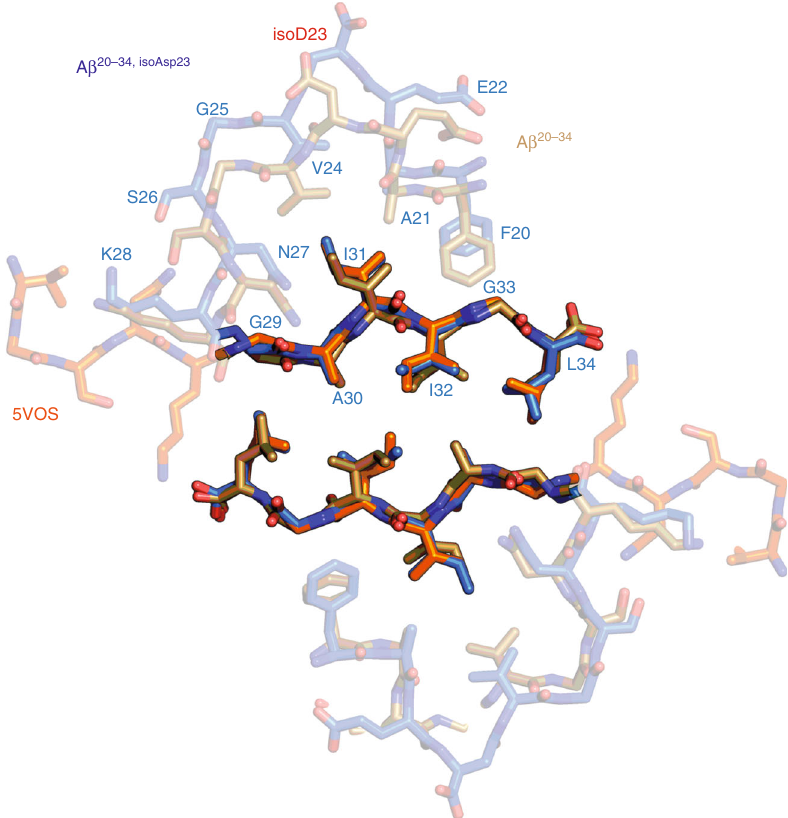
Fig. 7 A β 24 – 34 peptide structure shares similarities with the A β 20 – 34 structures. The A β steric zipper structure with the lowest total atom root-mean-square deviation of all the short A β segment structures, PDB: 5VOS 32 (orange), is shown aligned with interface A of A β 20 – 34 (gold) and A β 20 – 34, isoAsp23